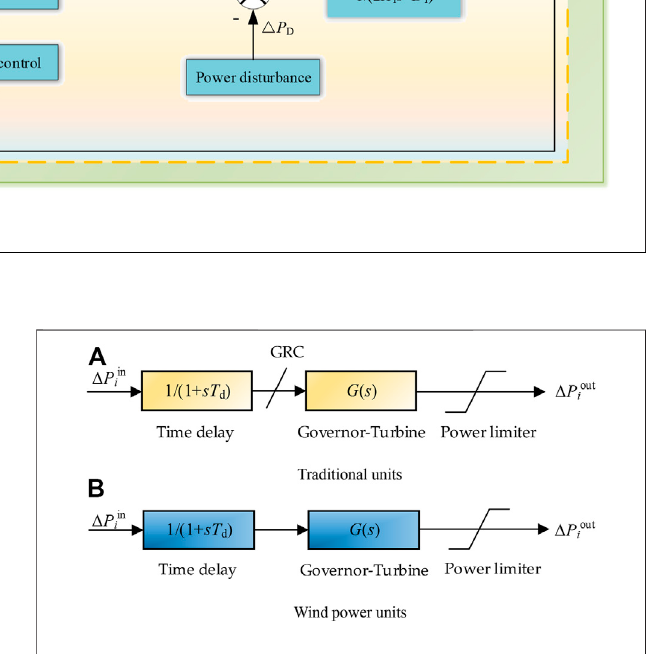
FIGURE 2 | Dynamic response models. (A) Traditional units. (B) Wind power